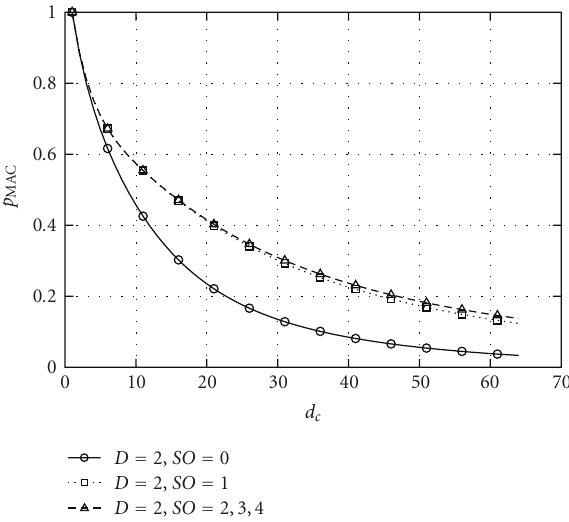
Figure 3: p MAC , as a function of d c , for di ff erent values of SO